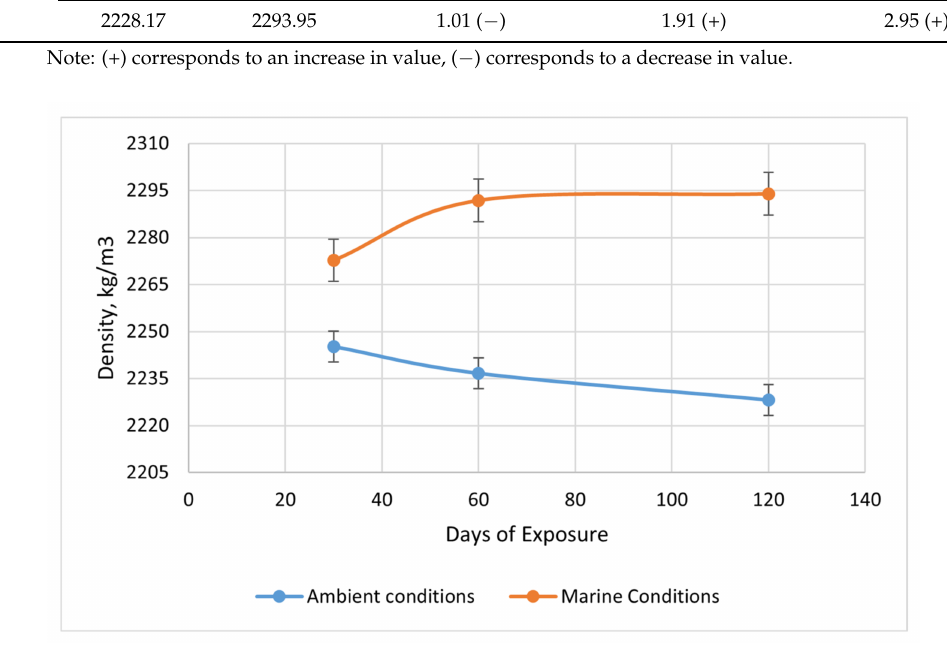
Figure 6. Density of ambient and marine exposed